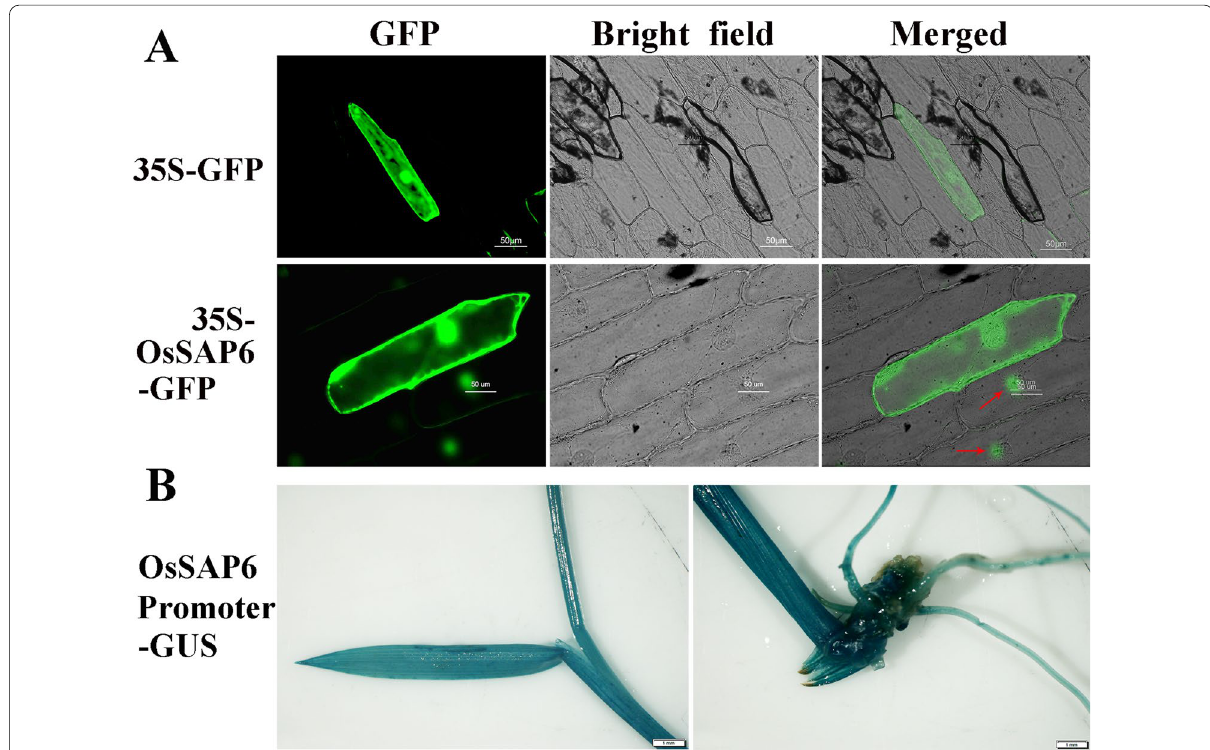
Fig. 2 Subcellular localization of OsSAP6 in onion epidermal cells and expression of OsSAP6 promoter-GUS. A GFP and OsSAP6-GFP driven by the 35S promoter under green fluorescence, bright field, and merged views. Bar, 50 μm. B Image of stereomicroscope after immersion in GUS stain and decolorization in 95% ethanol, Bar, 1